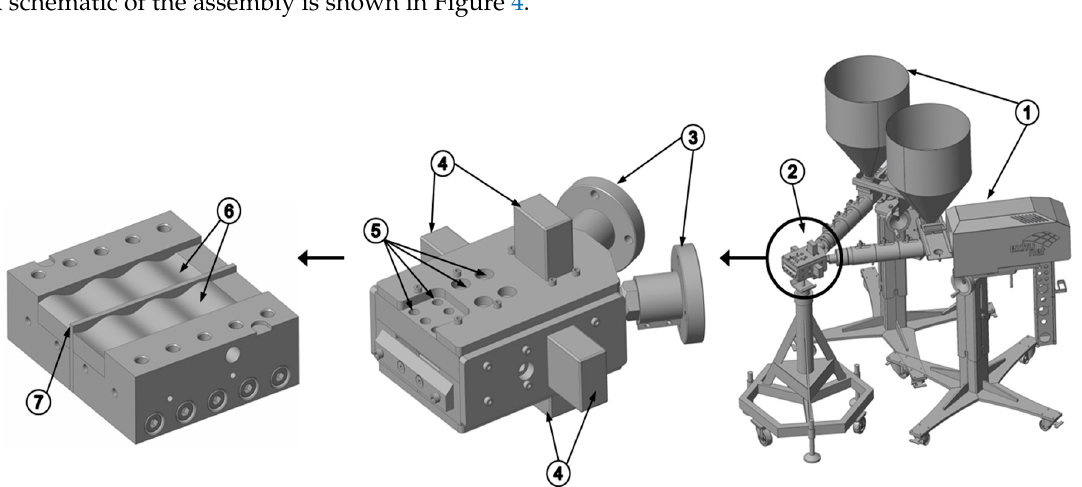
Figure 3. Comparison between experimental and calculated viscosity data at temperatures of 180 and 200 °C: ( a ) high-density polyethylene (HDPE) and ( b ) polypropylene random copolymer.